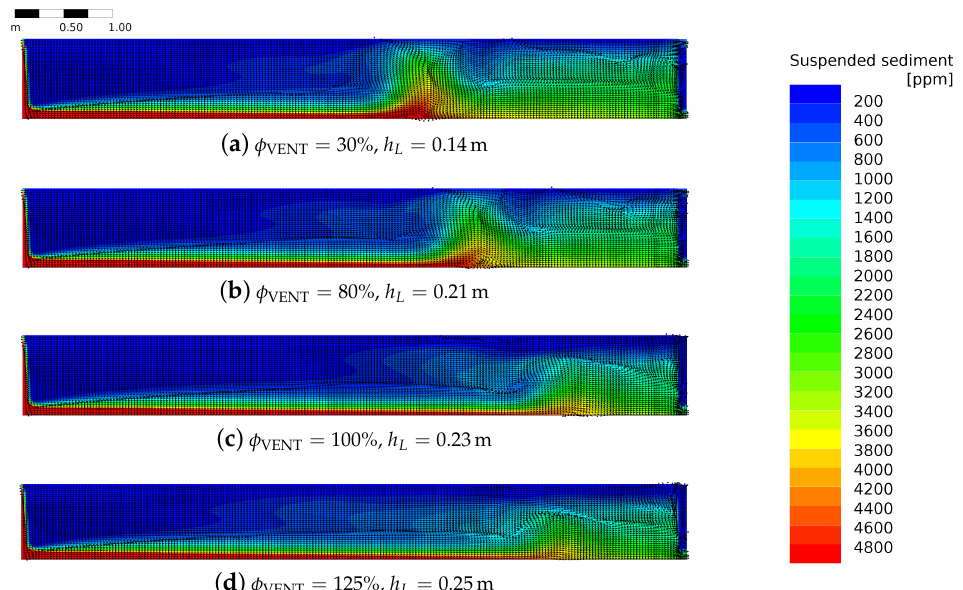
Figure 7. Longitudinal section through the sediment concentration field in the channel with suspended sediment concentration contours in ppm at different venting degrees φ VENT . The plots display a situation 350s after the start of venting when steady state conditions have been reached. The velocity field is displayed by velocity vectors (unscaled).